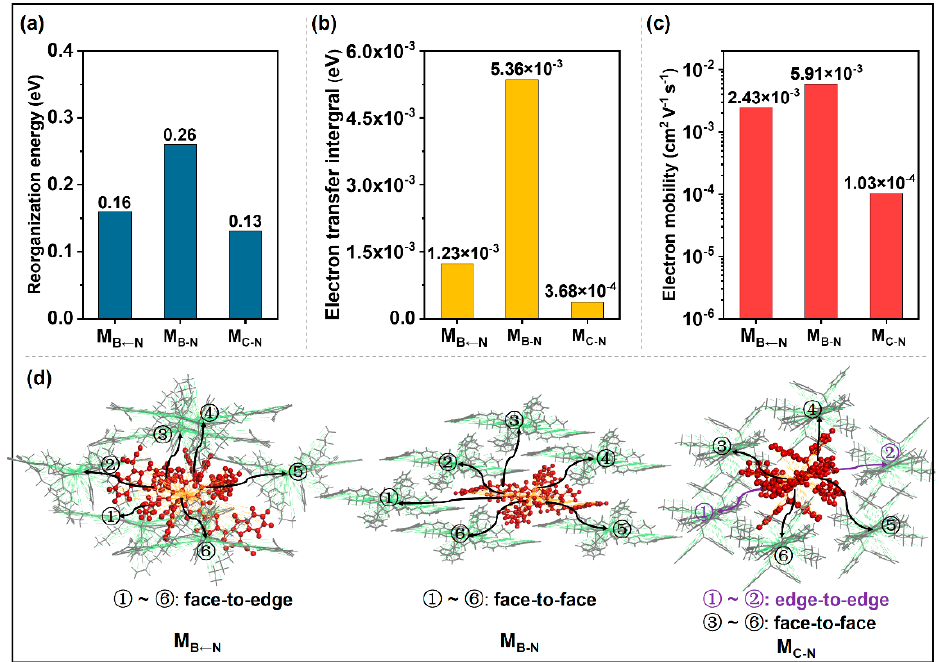
Figure 3. ( a ) Internal reorganization energy ( λ ), ( b ) maximum transfer integral ( v max ), ( c ) electron mobility ( μ e ), and ( d ) charge hopping pathways of the studied compounds.